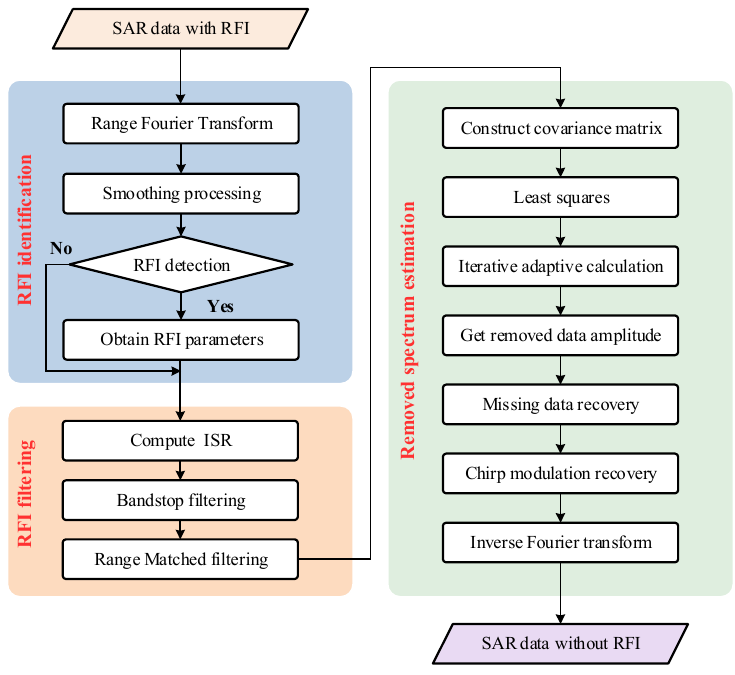
Figure 5. Flow chart of the proposed RFI suppression approach.